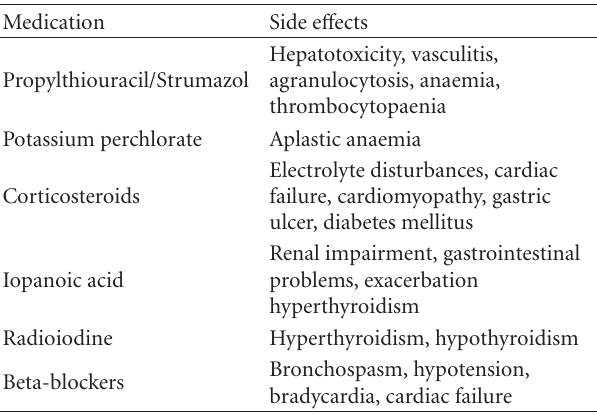
Table 1: Drugs in thyroid treatment and side e ff